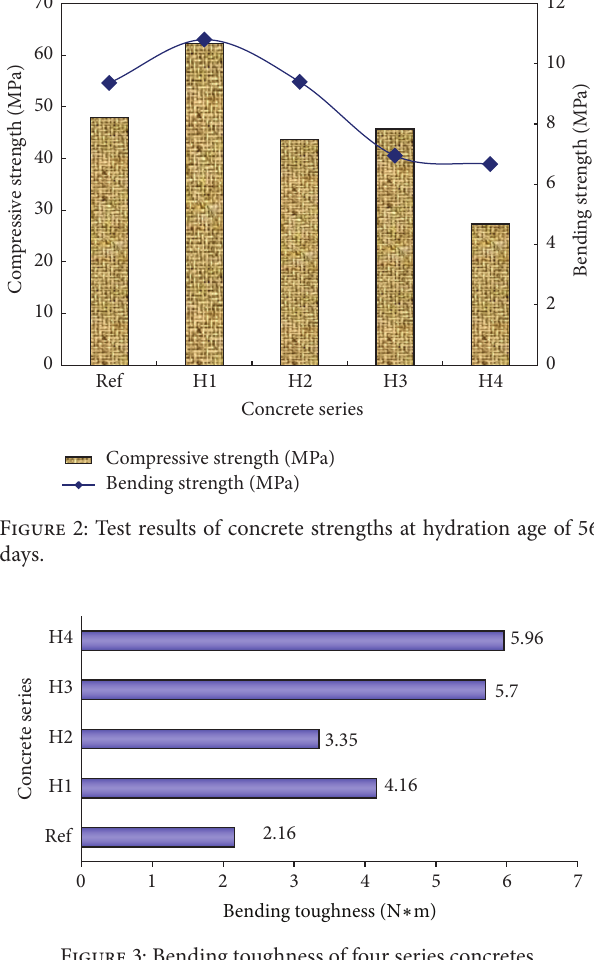
Figure 3: Bending toughness of four series concretes.